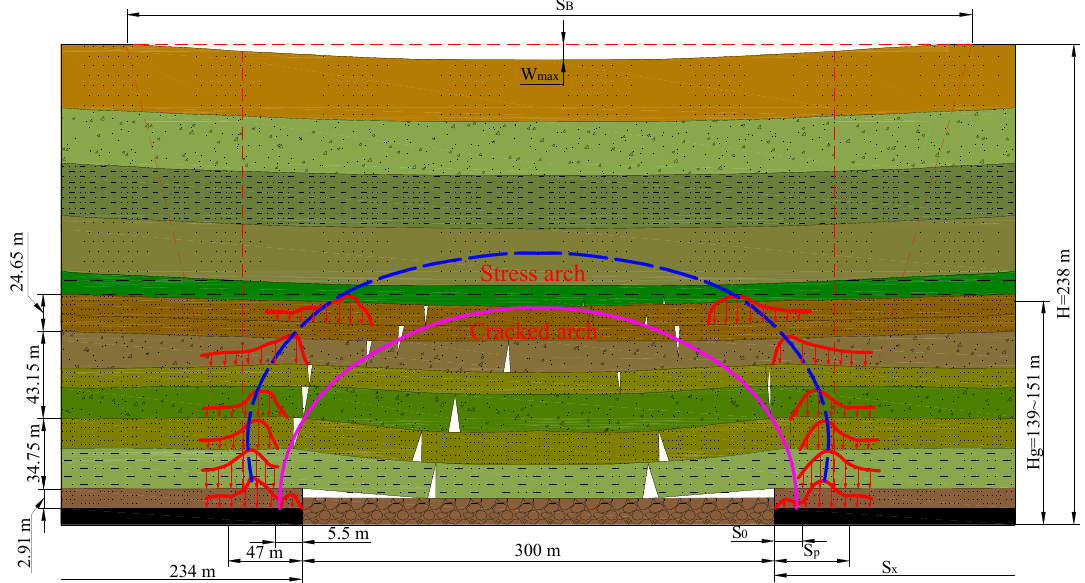
Figure 4. Main parameters of surrounding rock structure mechanics of 108 working face.